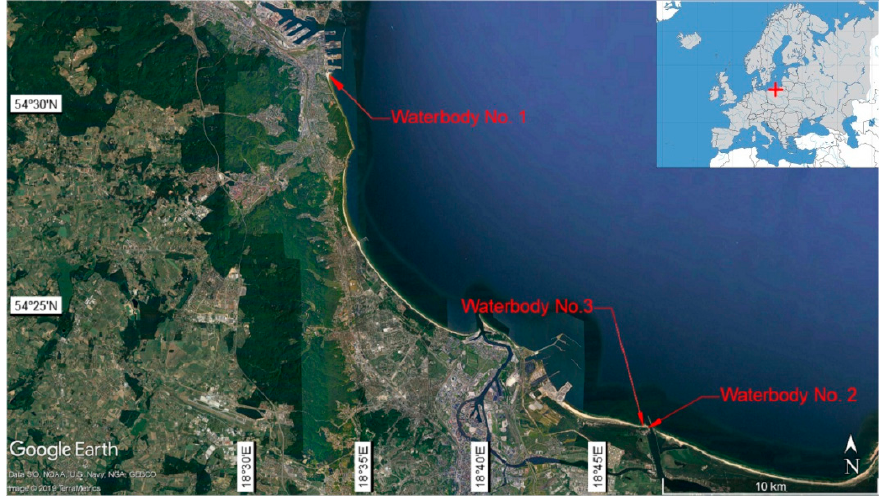
Figure 1. The geographic locations of the representative waterbodies.